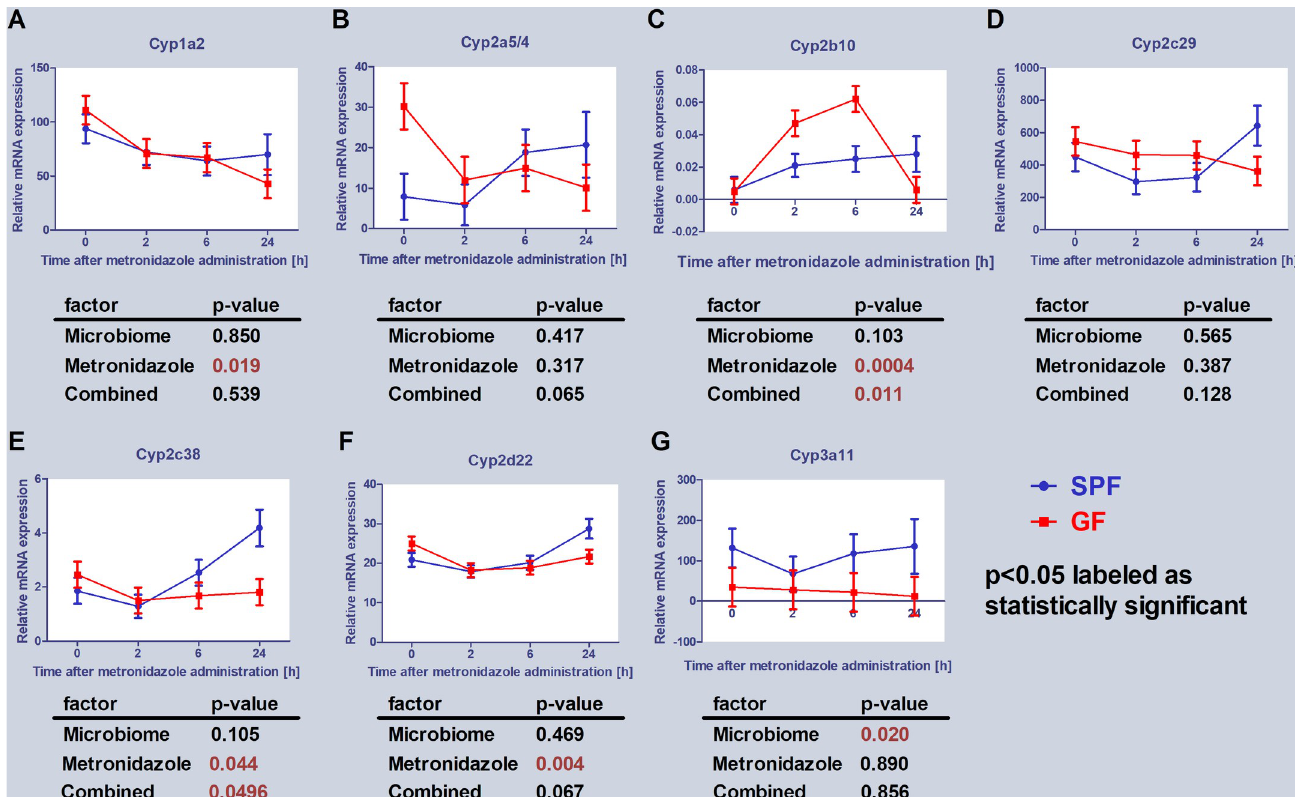
Fig 4. Expression of CYP enzymes. Comparison of estimated marginal mean values of mRNA expression of selected CYPs in relation with microbiome presence and metronidazole administration in mice liver. The data represent the mean ± SEM from 4 individual animals. The statistical significance was determined using two-way ANOVA and p-values for the effect of microbiome (i.e., difference between SPF and GF groups), metronidazole administration and combined effect of the both are shown in the tables below the respective graphs. Significantly different from control p < 0.05.